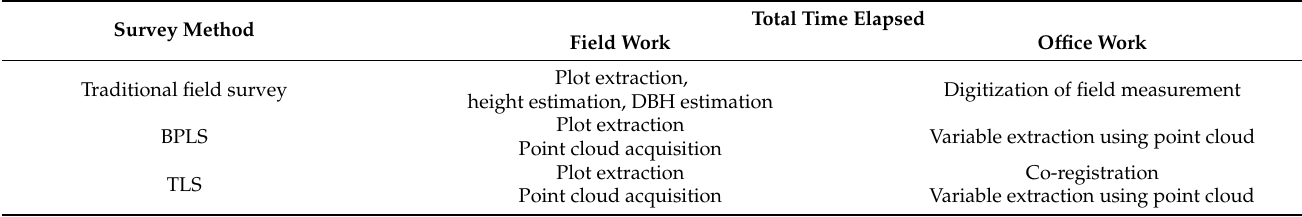
Table 4. Survey method categorization by device.